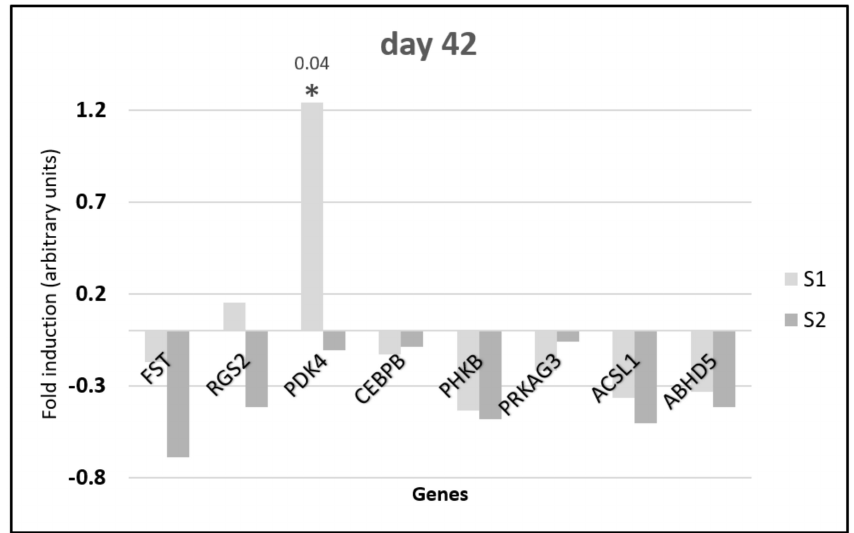
Figure 3. Changes in the relative expression of metabolic genes in the pectoral muscle of 42-day-old broiler chickens injected in ovo with synbiotics (S1) Lactobacillus salivarius with GOS or (S2) Lactobacillus plantarum with RFO. The analysis was performed using the ddCt method to determine gene expression changes (fold induction). Synbiotics were injected on day 12 of embryo development. Tissues were sampled on day 42 post hatching ( n = 5). Statistical analysis consisted of comparing the experimental groups with the control group by Student’s t -test (* for p < 0.05; exact p